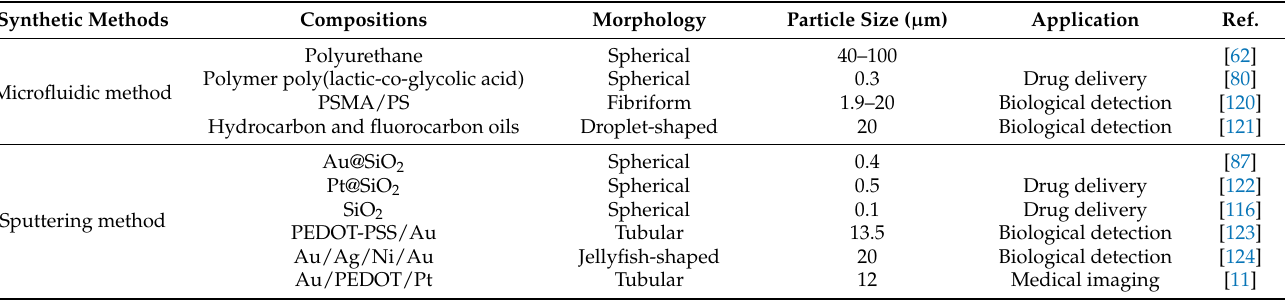
Table 1. Synthesis method, morphology and particle size of Janus